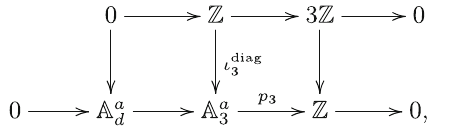
as a set. Then, we have the